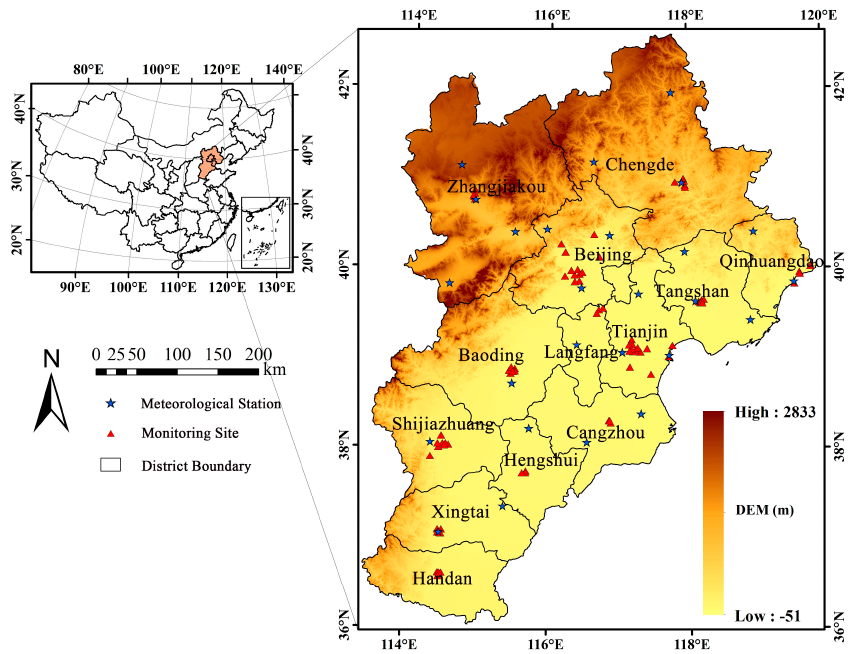
Figure 1. Sketch map of the Beijing-Tianjin-Hebei (BTH) region in this study.